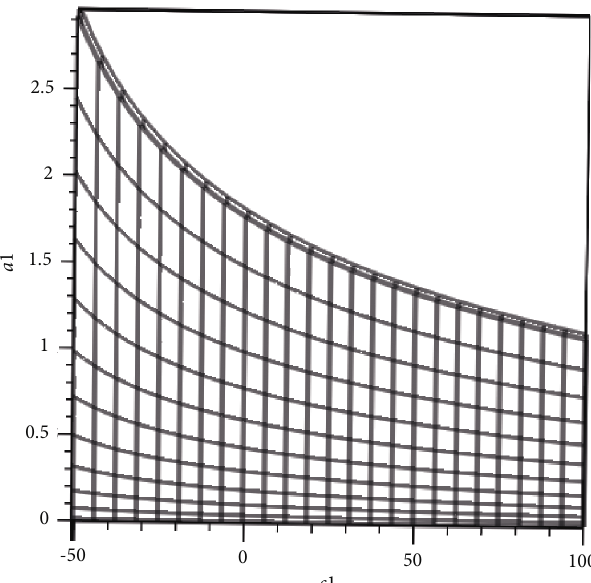
, c ,G ) on the 1 1 1 ≤ 100. 1